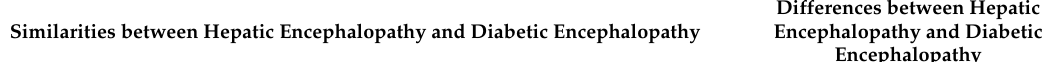
Differences between Hepatic Encephalopathy and Diabetic Encephalopathy